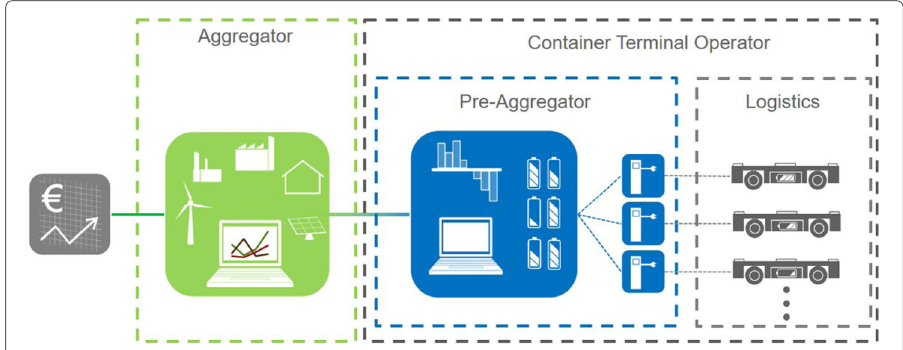
Fig. 3 FCR provision in logistics: energy-economic roles and system